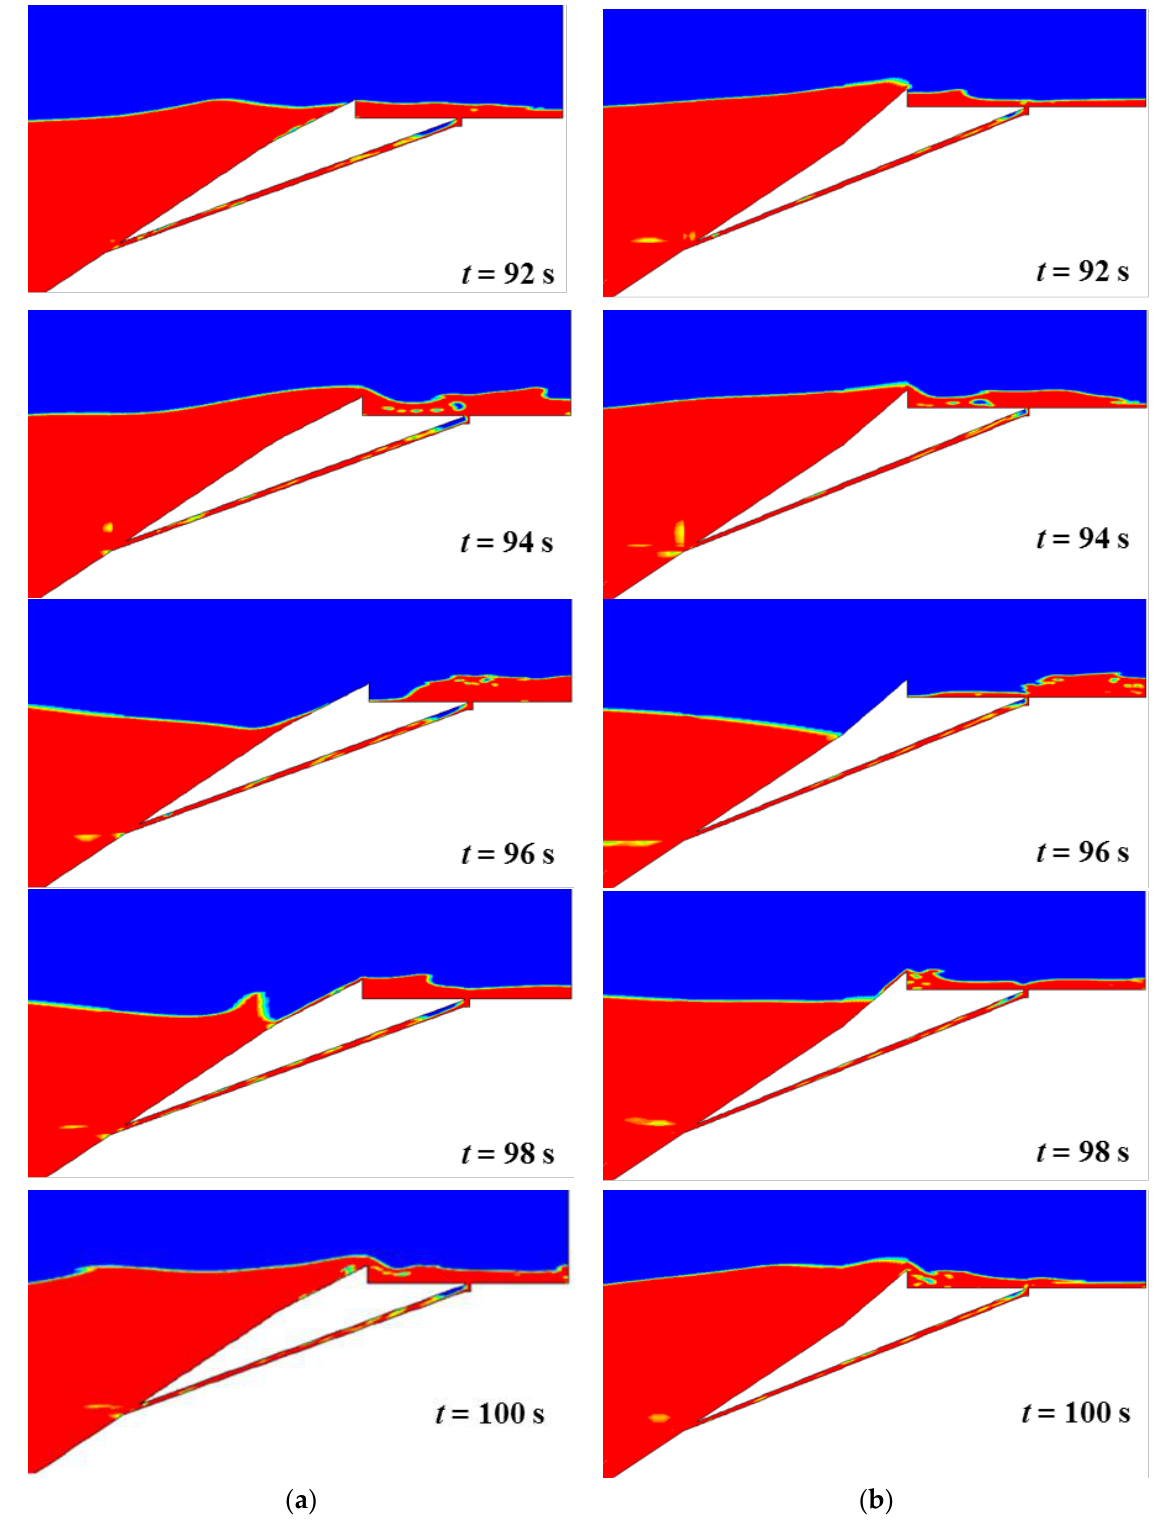
Figure 16. Hydrodynamic behavior of transient fluid flow for the instants t = 92 – 100 s: ( a ) the best geometry, case 1, H 1 / L 1 = 0.508 (26.95°); ( b ) the worst geometry, case 3, H 1 / L 1 = 0.852 (40.43°).